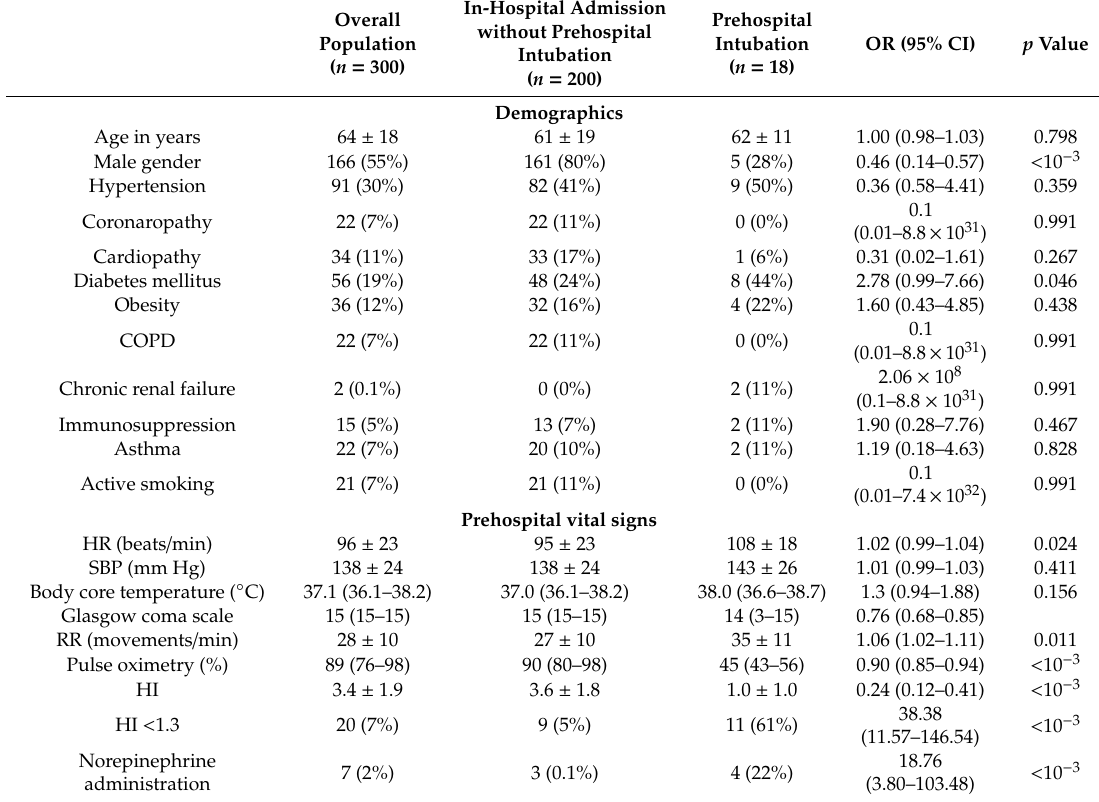
Table 1. Population demographics and clinical characteristics.